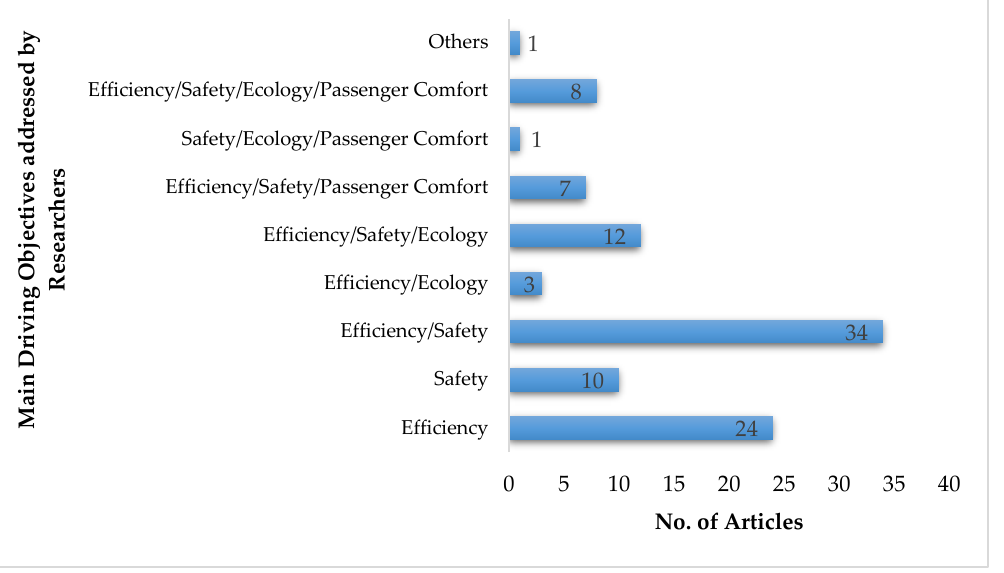
Figure 5. Categorization of different driving objectives in the major studies.